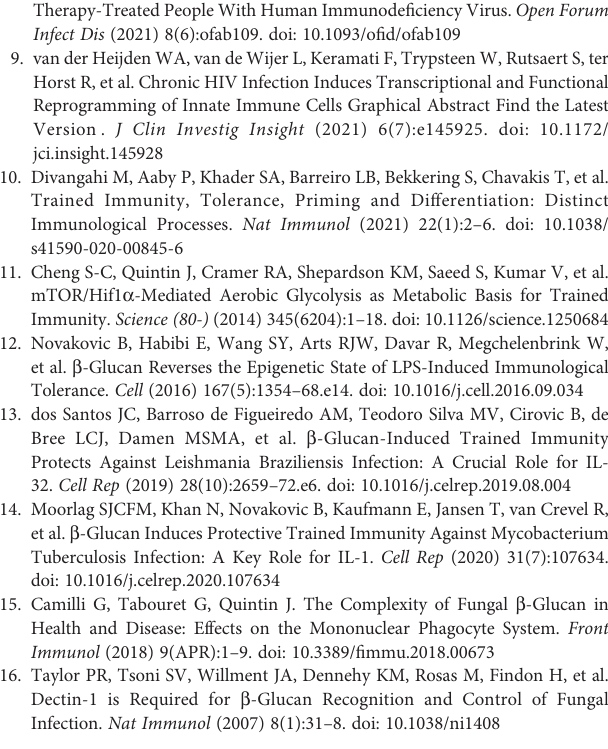
Supplementary Figure 2 | Longitudinal changes in epigenetic marks in monocytes after BDG exposure. (A, B) Clusters of differentially accessible regions identi fi ed in Figure 1A were queried for (A) H3K27ac and (B) H3K4me1 ChIP-seq signal in human monocytes after 0h, 1h, 4h, and 24h of BDG exposure. Data are presented as box and whisker plots with box representing median + interquartile range and whiskers representing 5 th and 95 th percentile marks. Red horizontal line denotes median tag count in 1kb of a speci fi c epigenetic mark at 0h after BDG exposure. P- values were calculated using paired one-way ANOVA with multiple comparisons. ns,notsigni fi cant; * P < 0.05; **P < 0.01;*** P <0.001; **** P <0.0001. Supplementary Figure 3 | Glutathione synthesis and metabolism in human monocytes before and after 24h stimulation. (A) Total intracellular glutathione levels in humanmonocytes at rest and after 24hof LPS or BDG exposure. (B) Intracellular GSH/ GSSGratioinhumanmonocytesatrestandafter24hofLPSorBDGexposure.Dataare presented as median ± standard deviation of n=3 biologically independent experiments. P- values were calculated using paired one-way ANOVA with multiple comparisons. ns, not signi fi cant; * P < 0.05; **P < 0.01; *** P < 0.001; **** P < 0.0001. Supplementary Figure 4 | ATAC-seq, ChIP-seq, and RNA-seq read density pro fi les at the NADK, NADK2, G6PD, PGLS, PGD , and TALDO1 loci. Supplementary Table 1 | Purity of monocyte isolations from PBMC using StemCell CD14+ monocyte negative selection kit. Supplementary Table 2 | List of clusters of differentially accessible regions after BDG exposure and gene ontology enrichment analysis of these clusters. Supplementary Table 3 | Groups of differential gene expression after 1h, 4h, 24h of BDG exposure and gene ontology enrichment analysis of these groups. Supplementary Table 4 | List of primers used for RT-qPCR